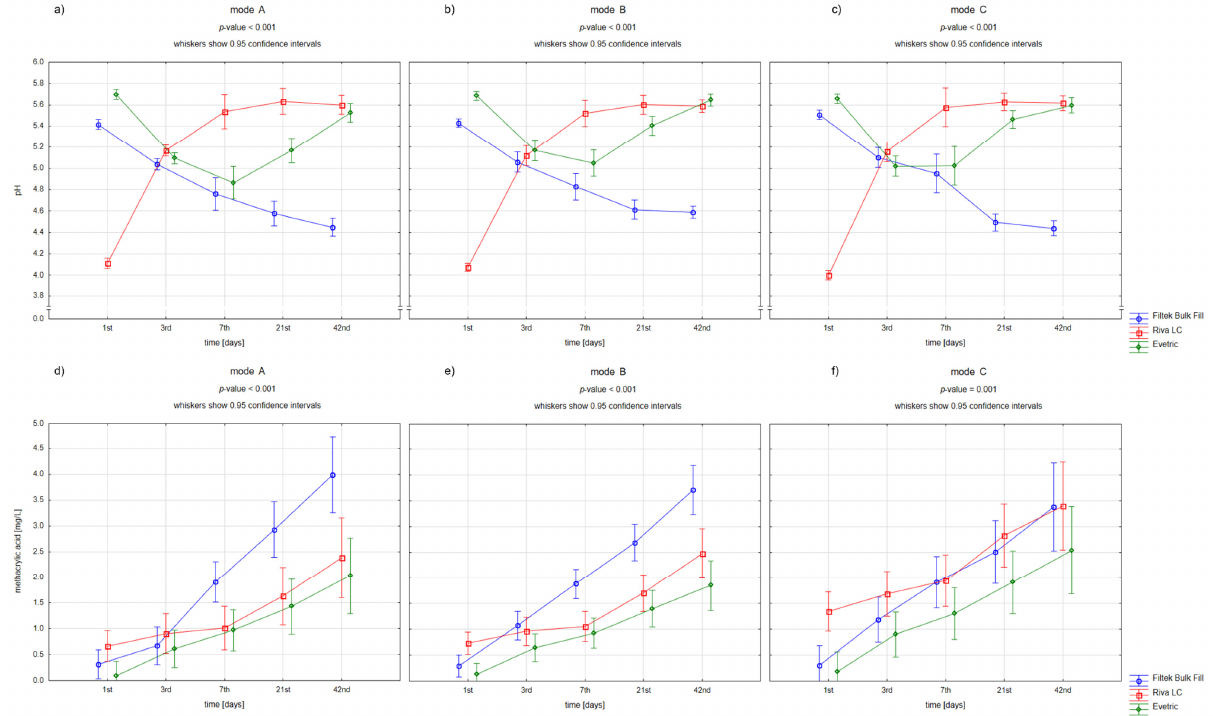
Figure 2. Repeated-measures analysis of variance for pH values ( a – c ) and methacrylic acid concentrations ( d – f ) in the individual timepoints for the used polymer- ization modes depending on the dental restorative material (A-full power mode, B-ramping mode, C-pulse mode).